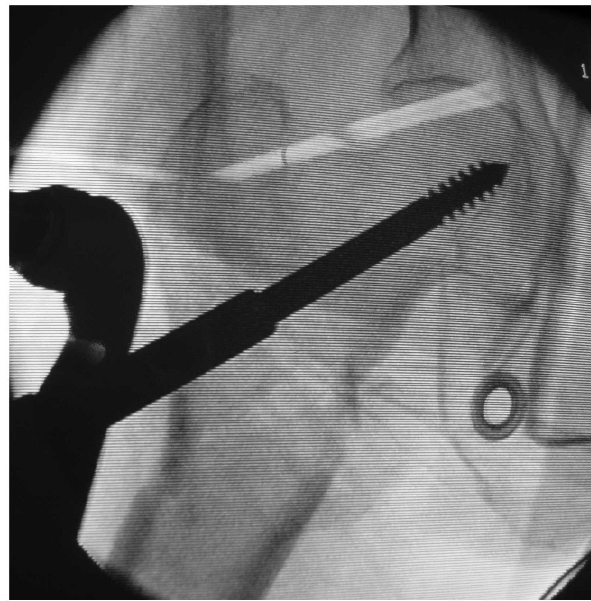
Figure 2 - Intraoperative radiograph of one patient. The entrance point avoided the fracture line during the placement of the first neck